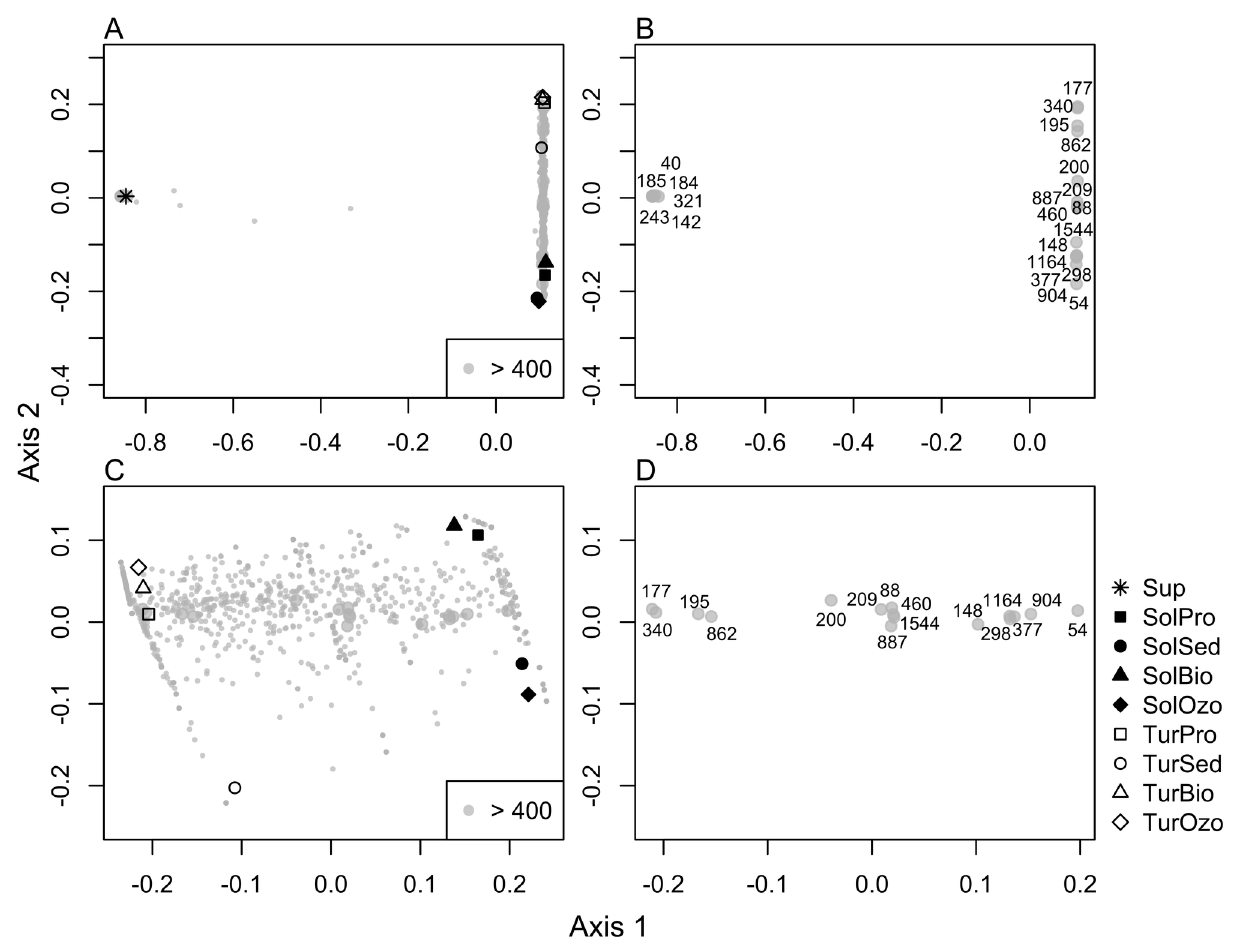
Figure 4. Ordination diagrams (PCO) of the bacterial community based on barcoded pyrosequencing data. (A) in all sampling compartments; (B) the most abundant OTU’s associated to all sampling points; (C) only in turbot and the sole sampling compartments (without water supply); (D) the most abundant OTUs associated to turbot and the sole sampling compartments. doi: